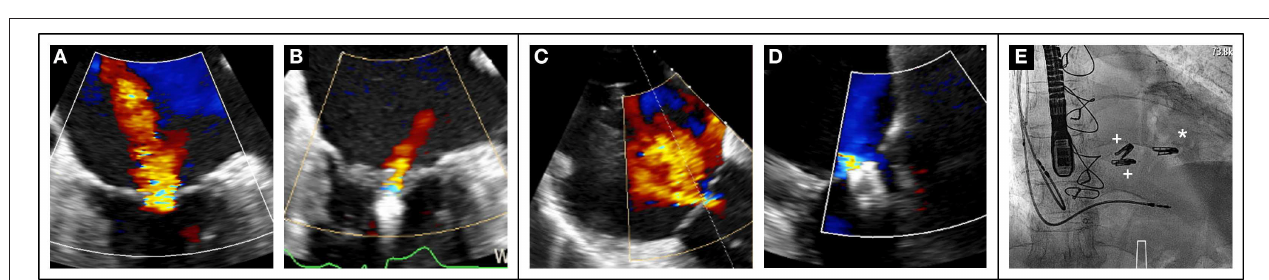
FIGURE 3 | Case of combined mitral and tricuspid edge-to-edge repair in a 79-year old sympatomatic (NYHA III) male patient with prohibitive surgical risk (Euroscore II 21%). Baseline transesophageal assessment showed severe MR (A) . After transseptal puncture, the mitral valve was treated first with the placement of one MitraClip XTR. with MR reduction to grade 1 + (B) . Severe TR at baseline (C) Two MitraClip XTR were placed in the anteroseptal commissure with reduction of TR to mild (D) . Final fluoroscopic result (( E ), *MitraClip mitral, + MitraClips